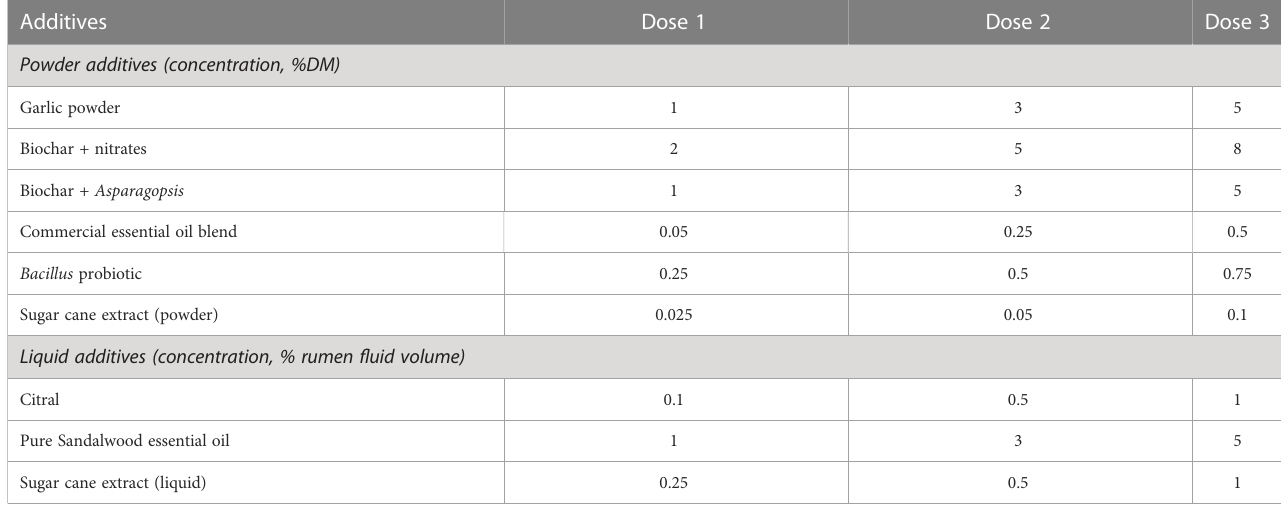
TABLE 1 Doses of powder and liquid additives evaluated in the In vitro batch culture incubation. Additives Dose 1 Dose